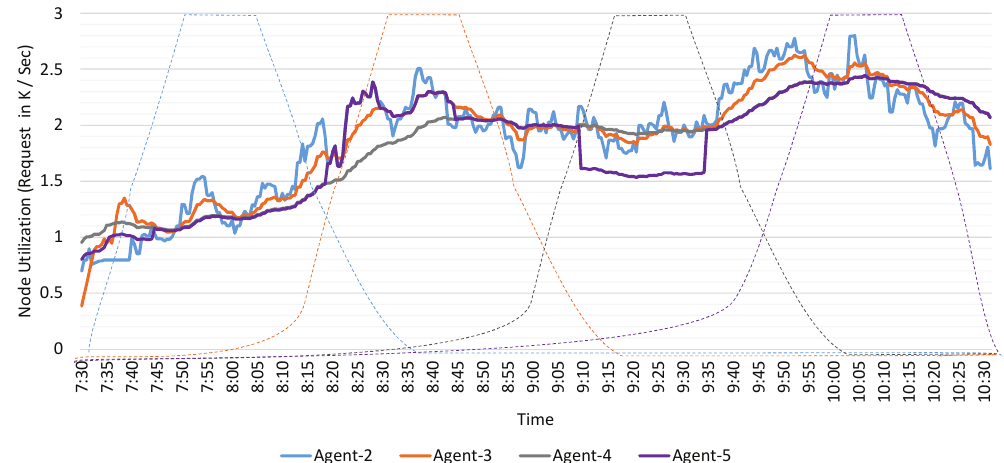
Figure 25. Performance evaluation of Intermediate Results (IR) Middleware.